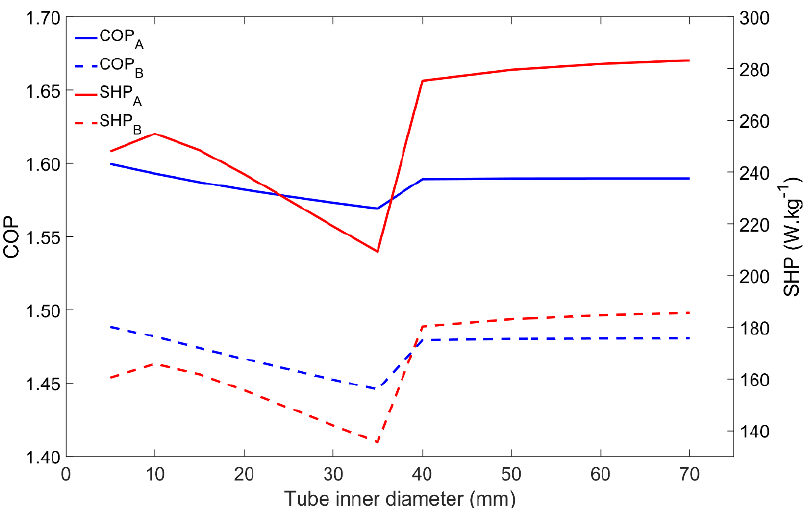
Figure 9. Impact of the inner tube’s diameter on the adsorber performance for scenarios A and B.